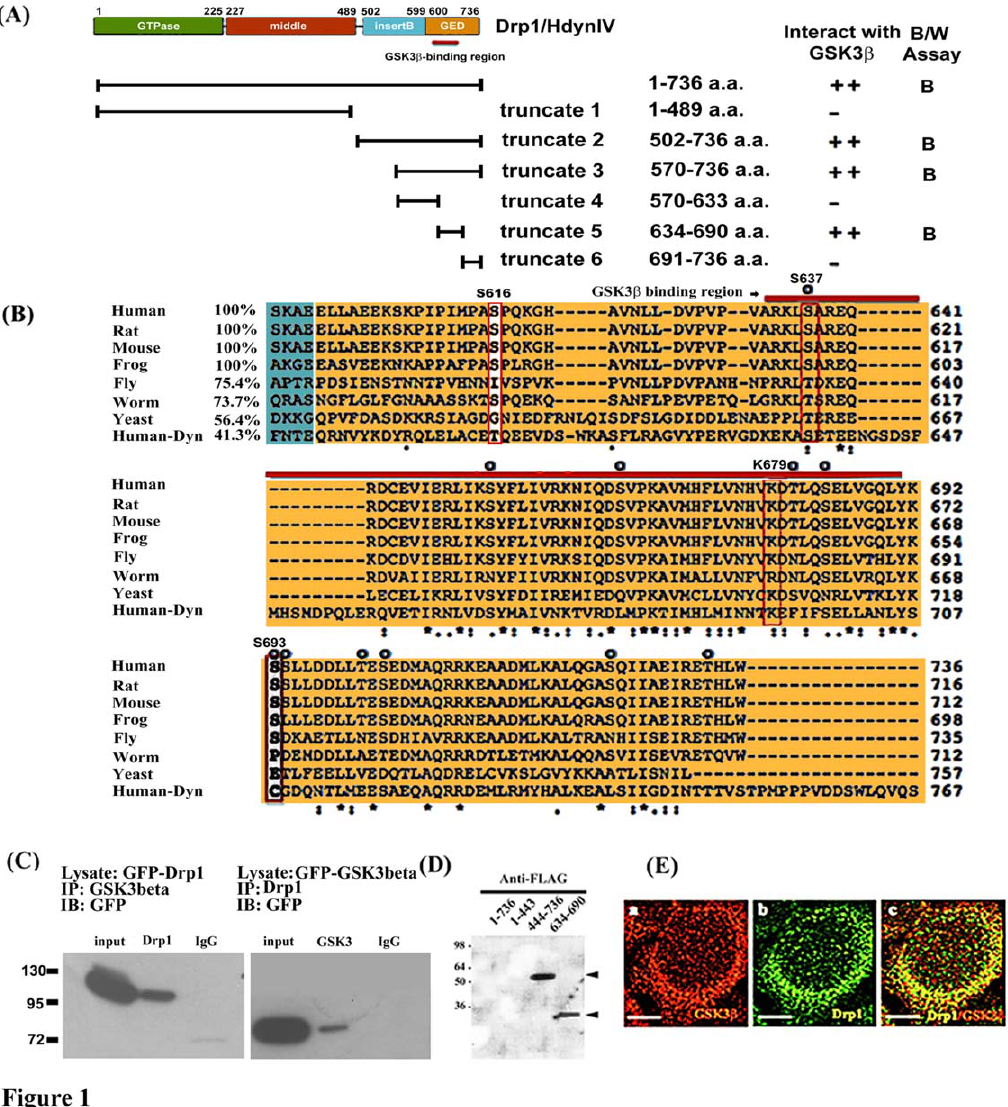
Figure 1. Interaction and co-localization of Drp1/Hydn IV with GSK3beta. (A) Schematic diagram showing the domain structure of Drp1 as previously described [7] and relative positions of truncated Drp1 constructs used in this study. Yeast two-hybrid assays showing interactions of various Drp1 constructs as bait (pAS2-1) with GSK3beta as prey (pACT-2) as indicated. Blue (B) and white (W) assay was applied for reporter gene beta-galactosidase expression. Strength of interaction was assayed by beta-galactosidase and HIS3 induction as described previously by Hong et al. [5]. (B) Specific binding region of Drp1 with GSK3beta is highly conserved. Multiple alignment of Drp 1 GED domain (colored in orange) was performed using ClustalW2 by which seven Drp1 homologues and human Dynamin 1 were aligned. Note the very high conservation in the GSK3 binding domain (BD, indicated by red bar) in Drp1 but not Dynamin 1 and Ser or Lys residues at positions corresponding to human Drp1 S637, K679, and S693 as indicated by red or white rectangles. Compared to human Drp1, the percentage of amino acid identity corresponding to each BD in GED is listed in front of the sequence. The prospective phosphorylated Ser/Thr residues are indicated by ‘‘O’’. (C) Total cell lysates were prepared from pEGFP C1-Drp1, pEGPC1-GSK3beta overexpressed 293 cells after transient expression for 24 hours, and subjected to co-immunoprecipitation (IP) assays with anti-GSK3 (left panel), anti-Drp1 (right panel), respectively. The anti-GFP antibody was used to detect the exogenous expressed GFP- tagged proteins in Western blotting (as indicated) which has been described in Materials and Methods. Data are representative of three independent experiments. The IP-Drp1 and IP-GSK3 represents the co-precipitated protein respects to antibodies used (D) The binding fashion of Drp1 634–690 and Drp1 444–736 fragment with GSK3beta was confirmed by far-Western blotting. Recombinant His-tagged fusion protein, either Drp1 full-length or truncated fragments of Drp1, was separated on 12% SDS polyacrylamide gel. Proteins were transferred into PVDF and incubated with HeLa cell lysate containing FLAG-tagged GSK3beta. Arrowhead indicates binding. (E) Co-localization study was performed by immunocytochemistry staining with confocal fluorescent microscopy as described in Materials and Methods. At 24 hours, 293 cells were stained with anti-GSK3beta antibody to detect endogenous GSK3beta (red, frame a). Frame b is the localization of endogenous Drp1 (green). Frame c is the merged image of the Drp1 and anti- GSK3beta stained cells. Bar=5 m m.